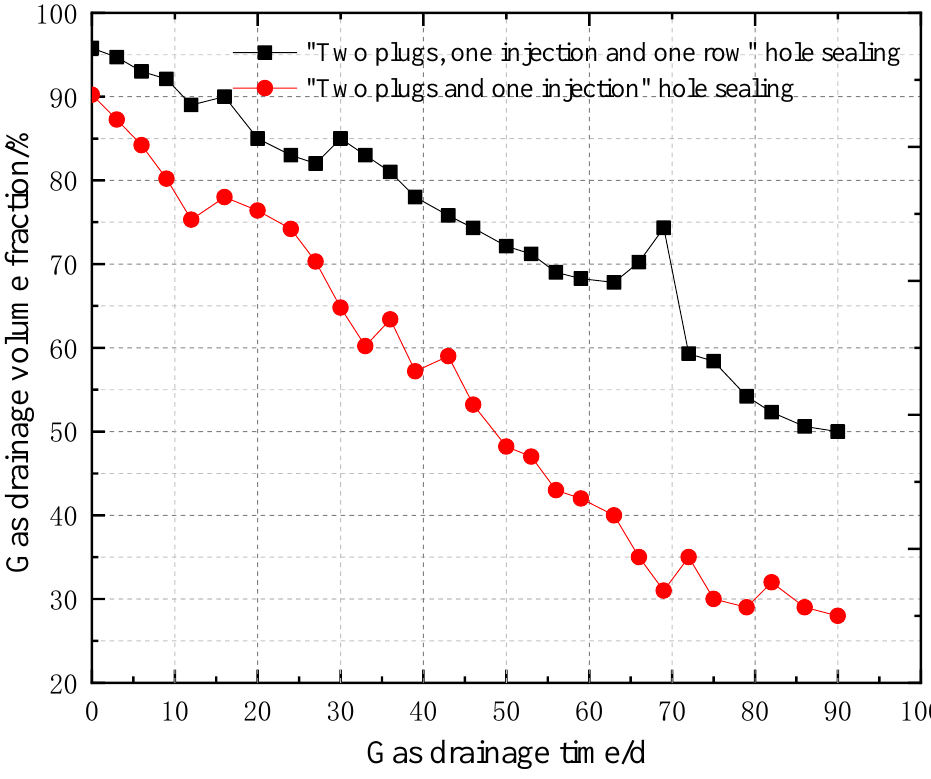
Figure 16. Comparison of gas volume fraction of two sealing methods.